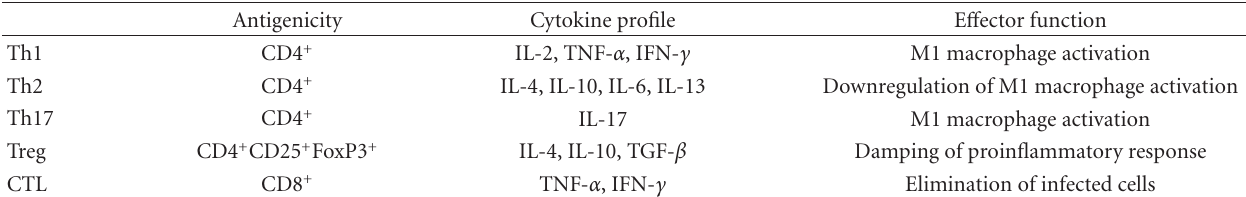
Table 2: The categorization of T cells into subsets is based on cell antigenicity, cytokine profile, and e ff ector